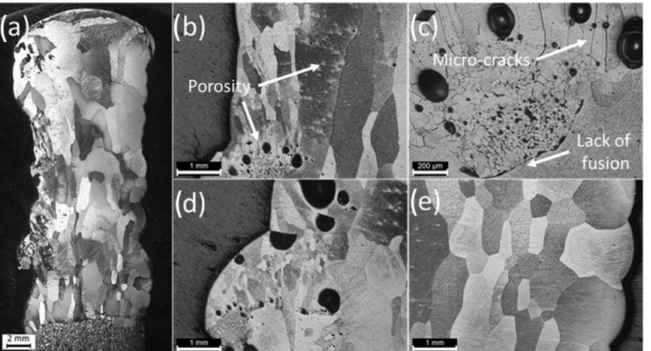
Figure 20. WAAM process parameters on the linear structures of unalloyed tungsten: ( a ) microstruc- ture defects using side wire feed; ( b – d ) details of the defects located on the side facing the wire feeder; ( e ) detail of the microstructure at the base of the linear structure. Reprinted with permission from Ref. [64]. Copyright 2019